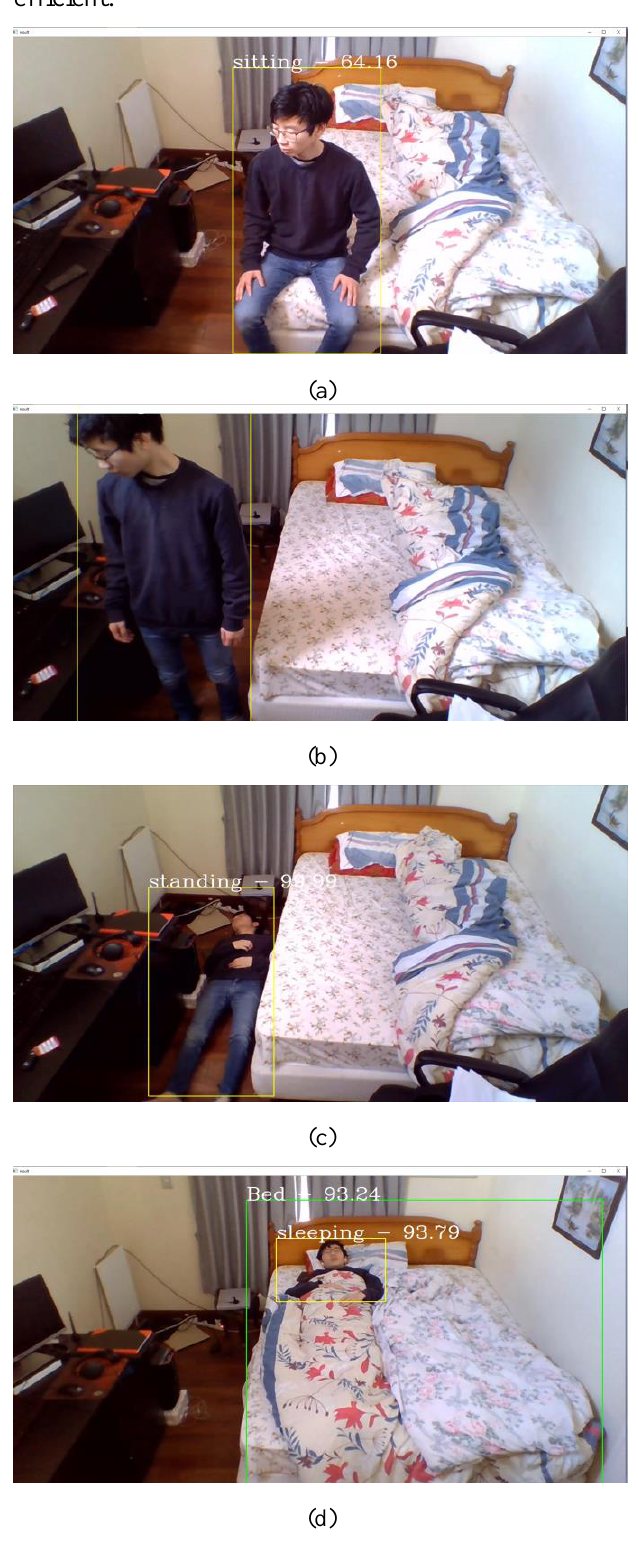
Fig. 6. Example of the detected and recognized postures with percentage confidence, (a) Example of sitting results, (b) Example of standing results, (c) Example of incorrect lying results, (d) Example of resting results with bed